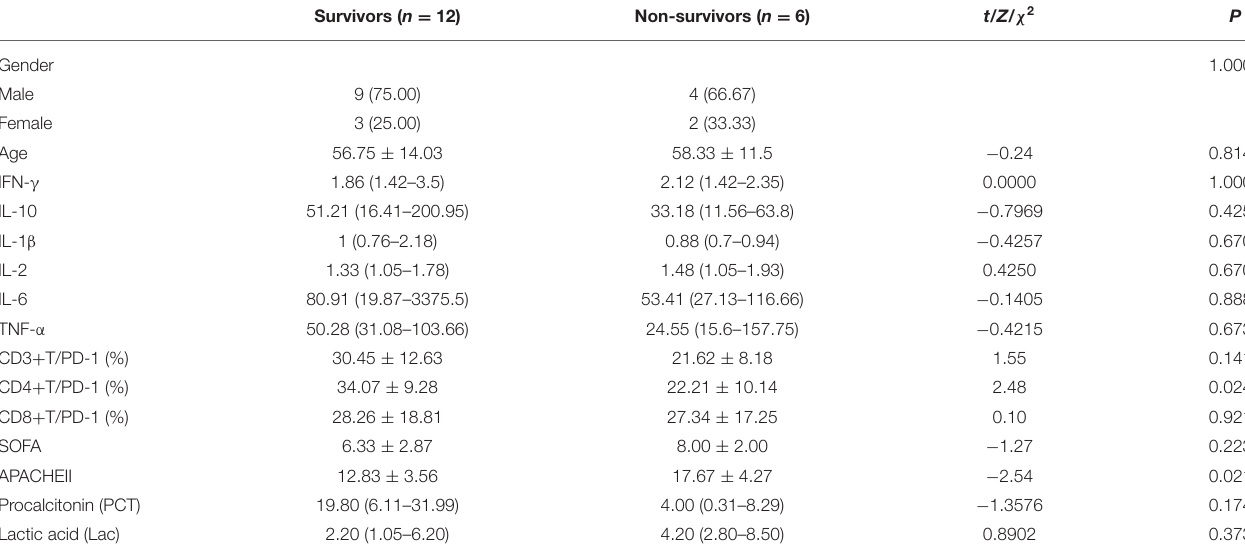
TABLE 1 | Comparison of relevant indexes of patients between 7-day survival group and 7-day death group.